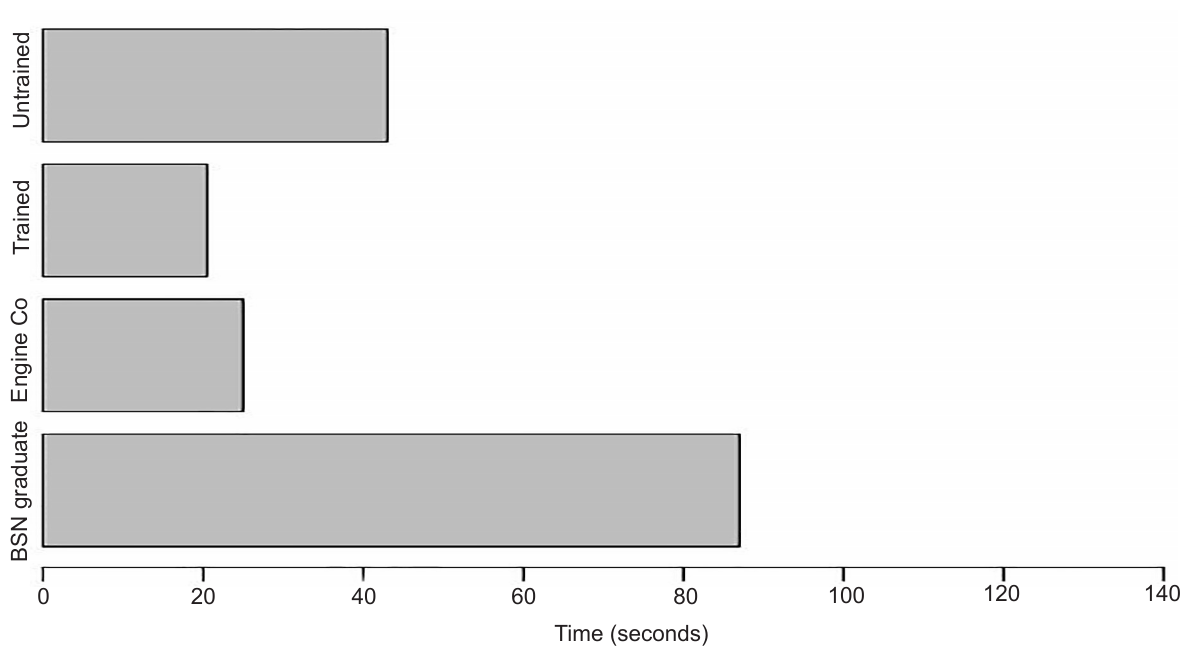
Figure 2. Time to First Action, of trained versus untrained groups in compromised airway scenario, as well as emergency medical services and health care professionals = nursing graduates.